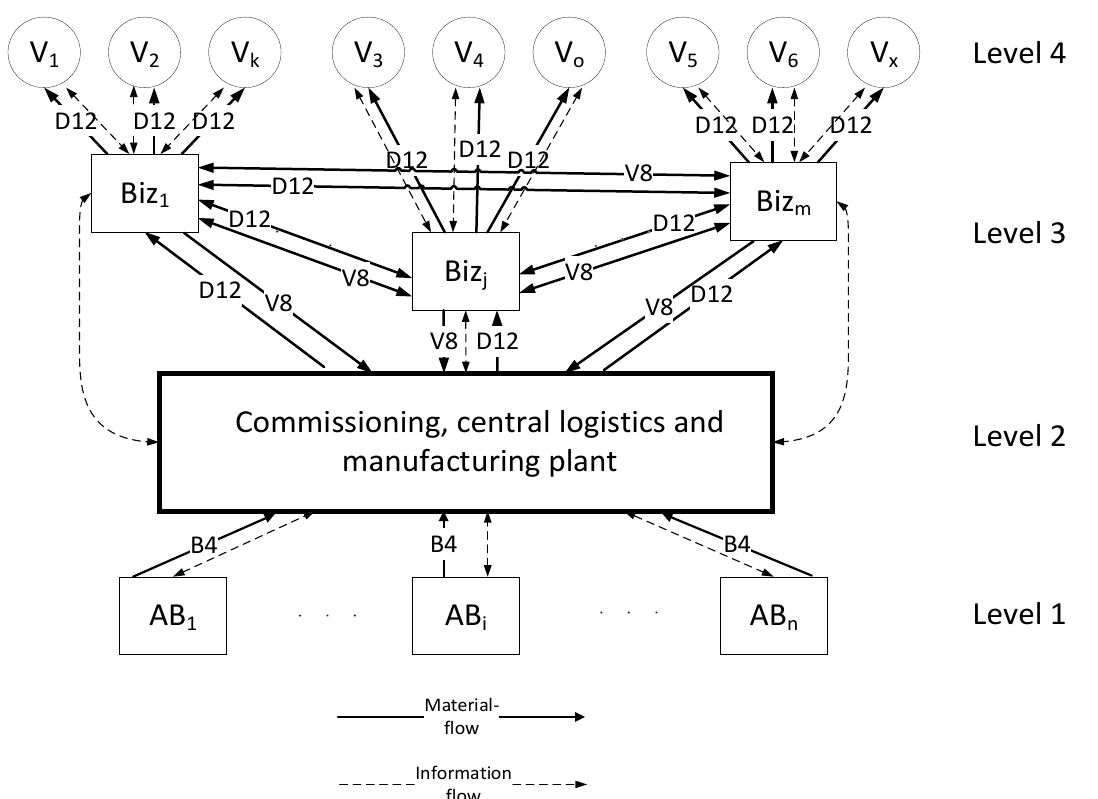
Figure 6. Relationship structure of companies producing dietary supplements that can be examined in a commission (Source: Self-edit).